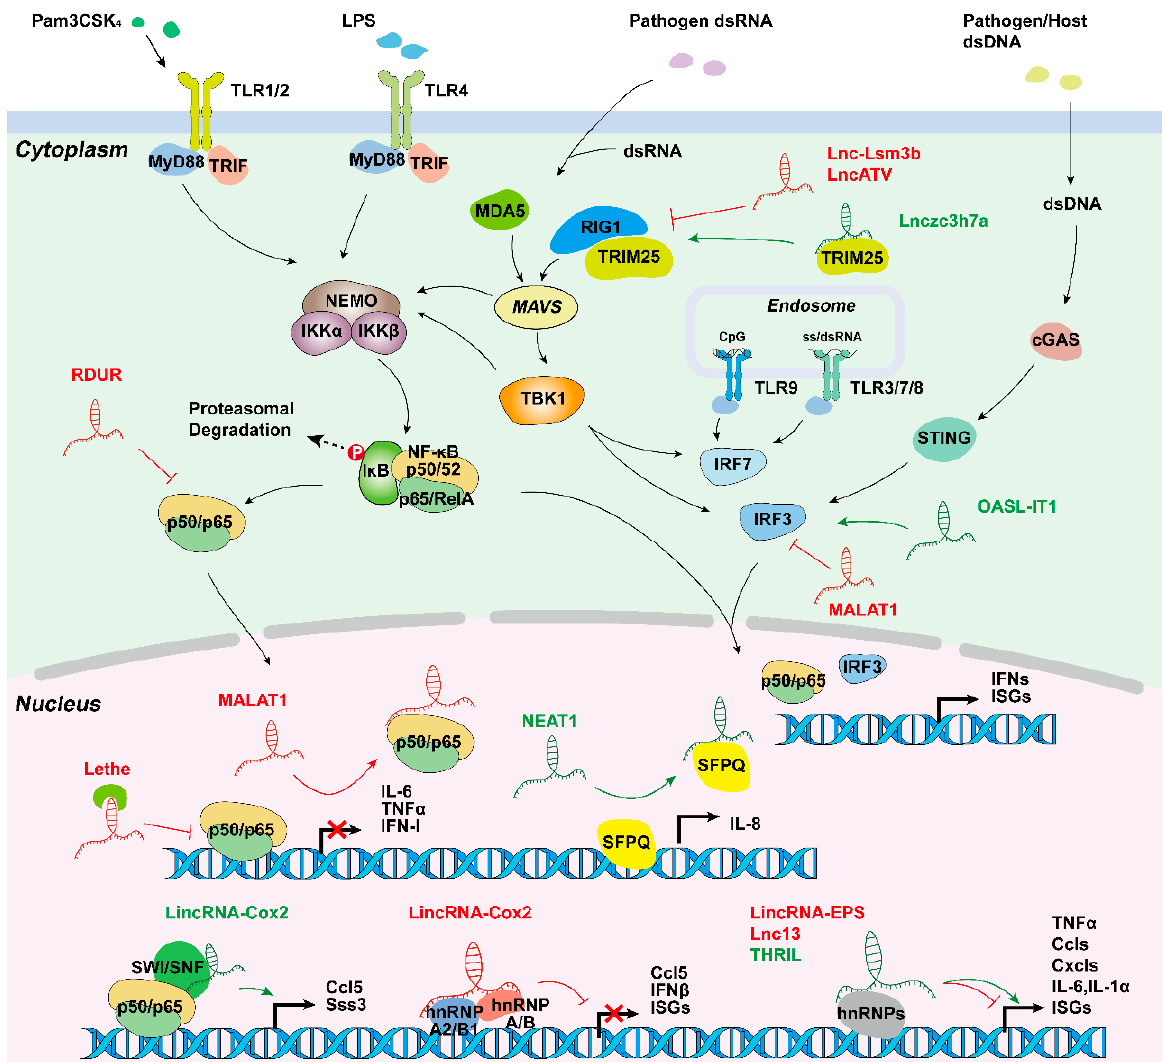
Figure 3. Long non-coding RNAs involved in innate immune responses. LincRNA-Cox2 activates or represses inflammatory genes through SWI/SNF-NF- κ B complex or interactions with hnRNP-A/B and hnRNP-A2/B1; Lethe inhibits NF- κ B locating target gene promoters; MALAT1 creates RNA-protein complex; NEAT1 initiates transcription by transferring SFPQ; and several other lncRNAs are involved in inflammation and virus-mediated innate immune response. hnRNP, heterogeneous nuclear ribonucleoprotein; SWI/SNF, switch/sucrose.